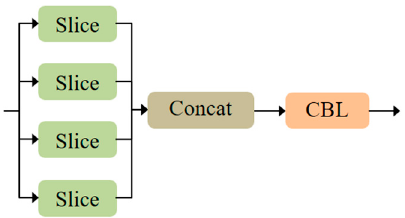
Figure 3. Composition of the “Focus” block.